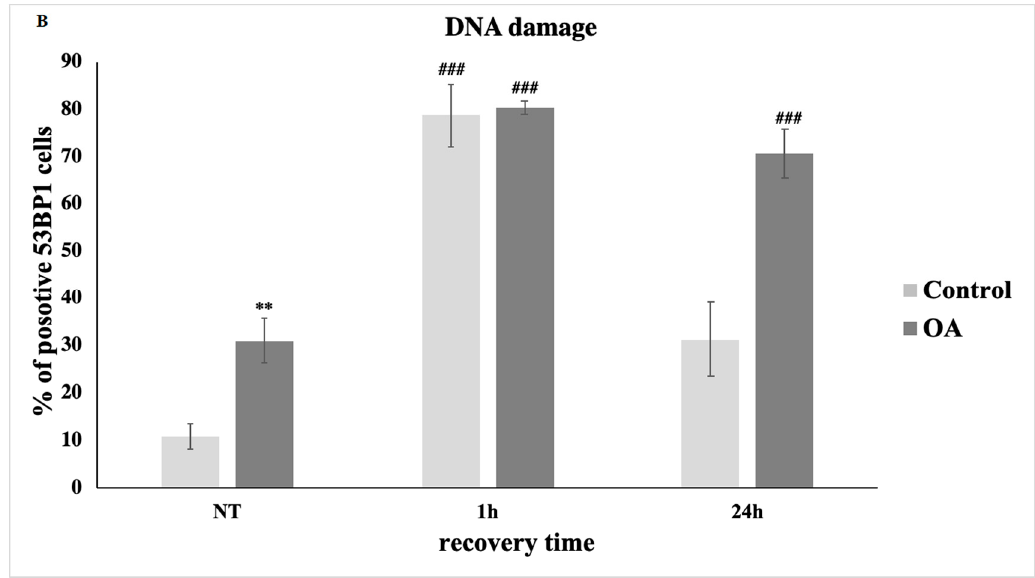
Figure 7. No translocation of caveolin-1 in osteoarthritic chondrocytes resulted in no restoration of damage. ( A ) Characteristic images of the control and OA chondrocytes where caveolin-1 localization was evaluated by staining with the anti-cav-1 antibody and the appropriate secondary antibody (red) under normal conditions (No Treatment—NT) and at 1 h and 24 h after being treated with H 2 O 2 . DNA damage was assessed by staining with the 53BP1 antibody and the appropriate secondary antibody (green). Nuclei were stained with DAPI (blue). Images were captured with the 40 × objective lens of the fluorescence microscope. Scale bar 25 µ m. ( B ) Percentages of chondrocytes with 53BP1 foci from three control and three OA patients samples evaluated by staining with the 53BP1 antibody under normal conditions (No Treatment—NT) and at di ff erent time points of the recovery period from the oxidative treatment (1 h and 24 h). Nuclei bearing > 5 foci stained with 53BP1 were counted as positive. Values shown are the means ± S.E. ** p < 0.05 vs. control cells and ### p < 0.001 vs. NT. p values were calculated using the Student t -test.